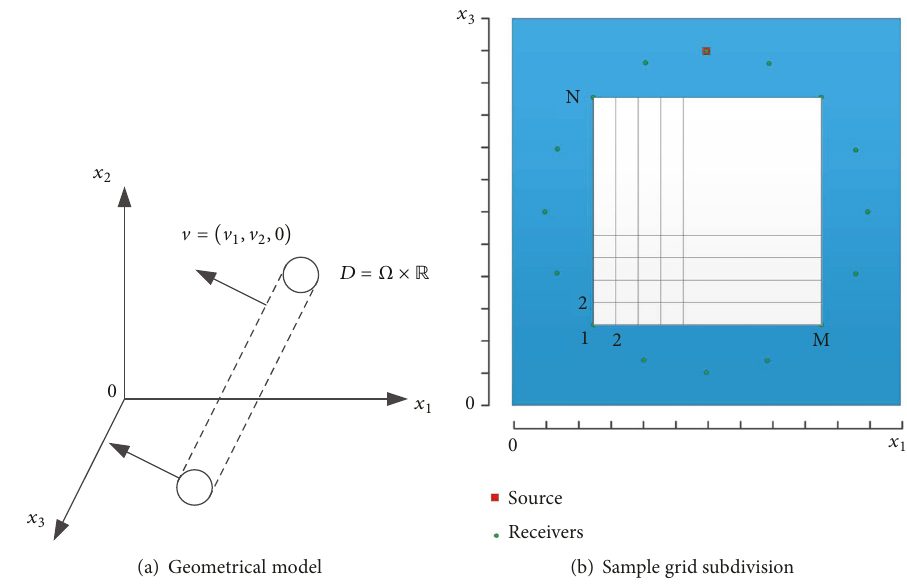
Figure 1: Geometrical